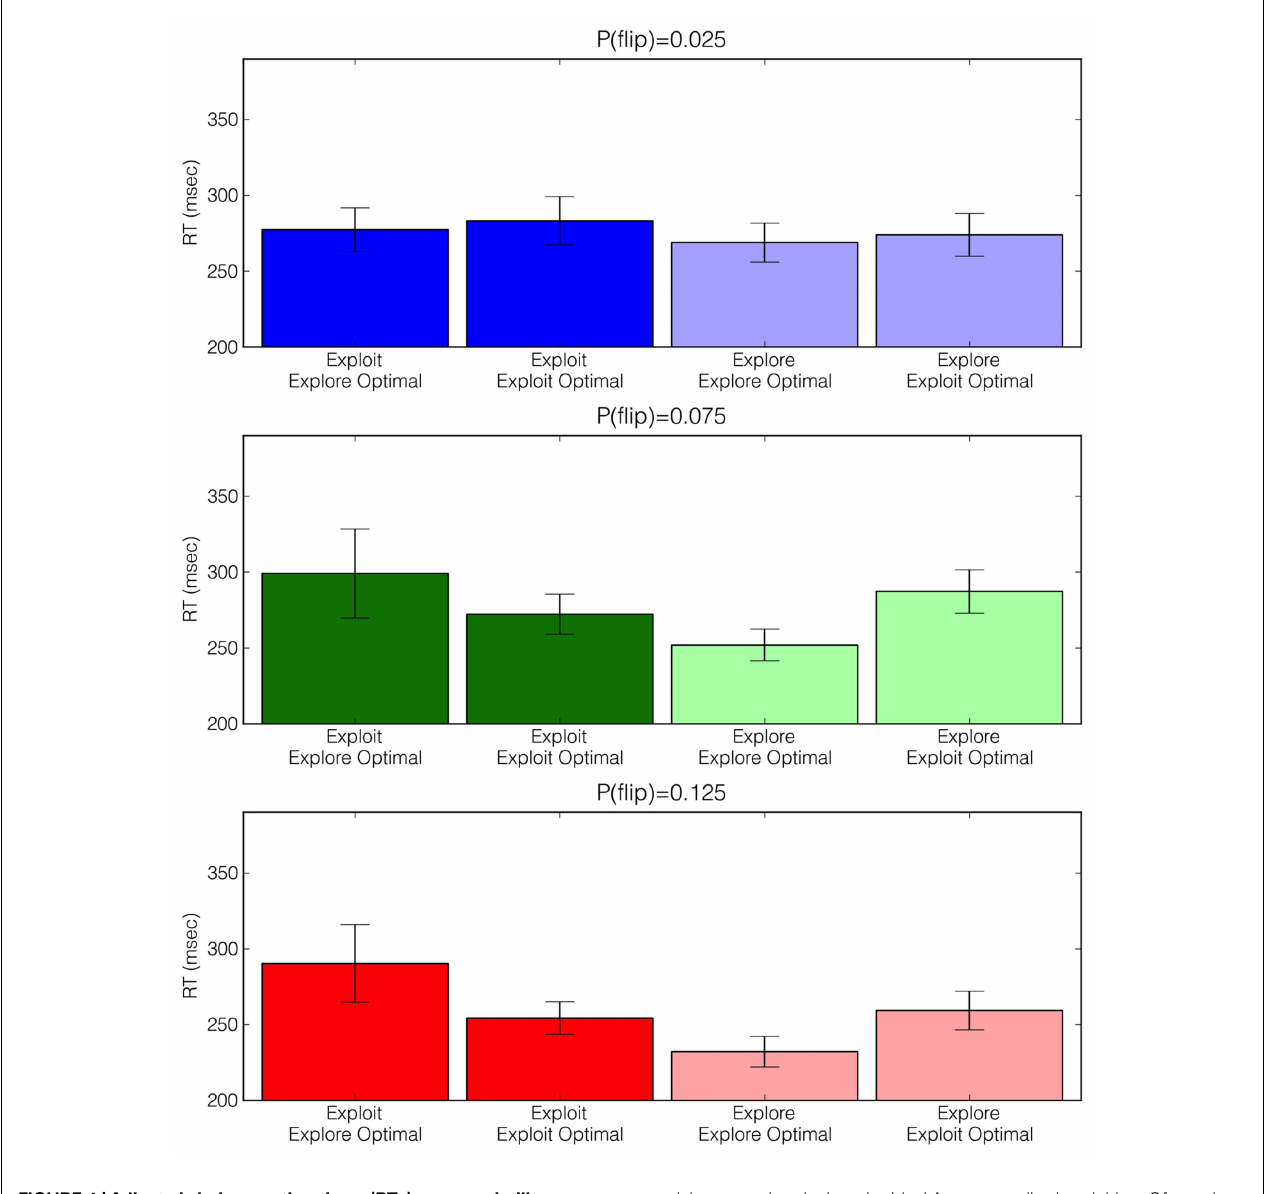
FIGURE 4 |Adjusted choice reaction times (RTs) across volatility conditions as a function of choice type (exploratory versus exploitative) and IdealActor choice prescription (exploit optimal versus explore optimal). For example, the far right bars represent situations in which